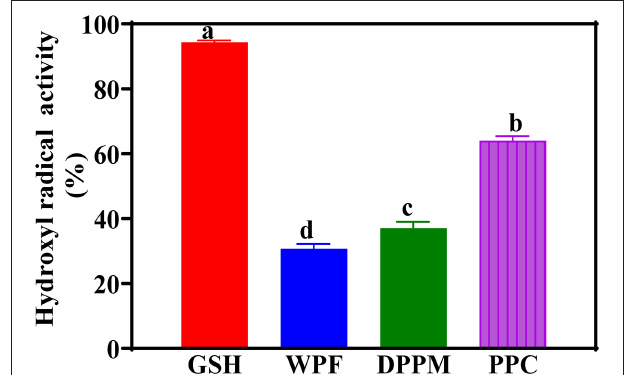
FIGURE 2 | Superoxide radical scavenging activities of different peanut protein preparations (WPF, whole peanut flour; DPPM, defatted peanut protein meal; PPC, peanut protein concentrate) in comparison to glutathione (GSH) a natural antioxidant. Values are means ± std and bars with different letters are significantly different at p < 0.05.